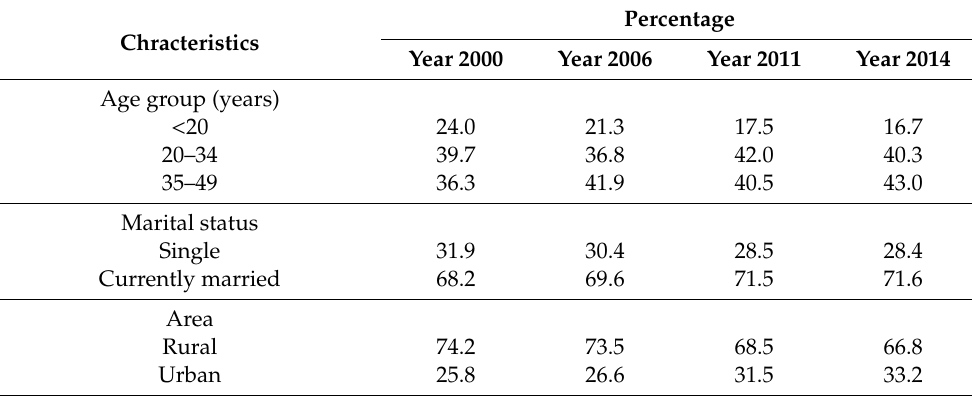
Figure 1. Trends in the percentage and 95% confidence intervals of comprehensive knowledge of HIV among women aged 15–49 years in Vietnam (weighted), 2000–2014. Table 1. Characteristics of women aged 15–49 years in the study according to various factors (weighted),